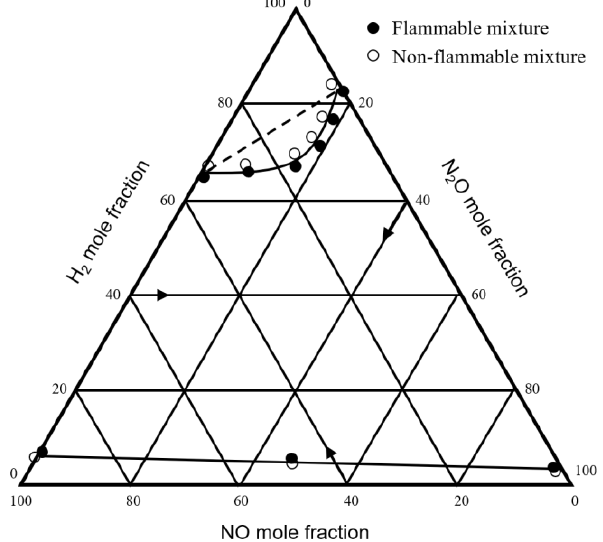
Figure 4. Measured flammability limit of H 2 -NO-N 2 O at normal temperature and pressure. The dashed line represents the calculated upper flammability limit (UFL) by the Le Chatelier Law. Reproduced from Ref. [32], The Combustion Institute: 1957.